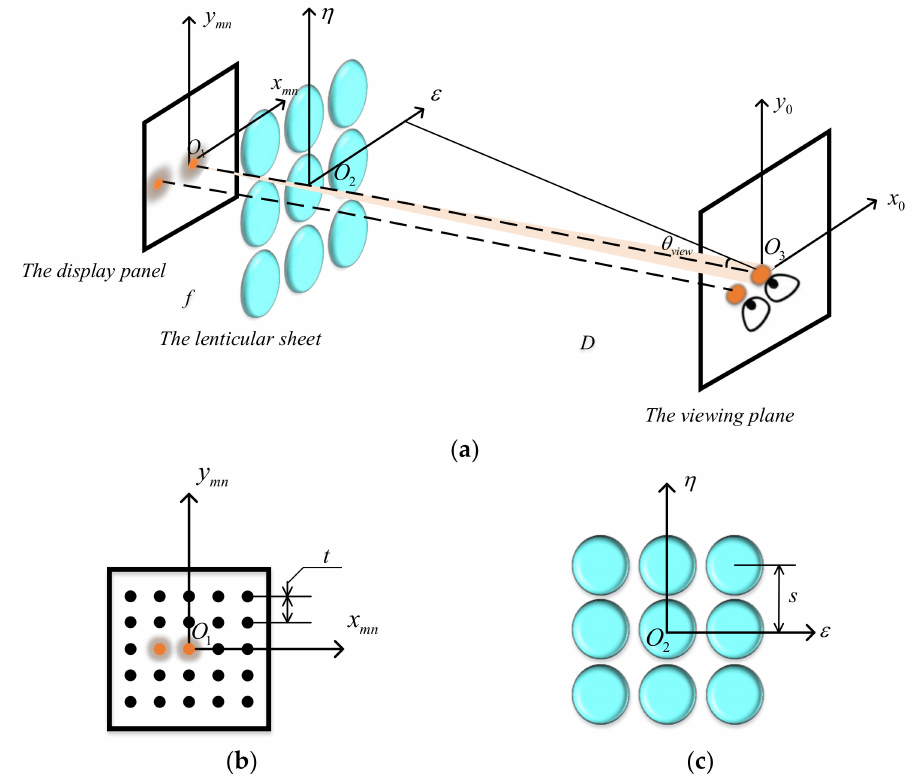
Figure 1. ( a ) A typical autostereoscopic display system using lenticular sheet; ( b ) the display panel plane; and ( c ) the lenticular sheet